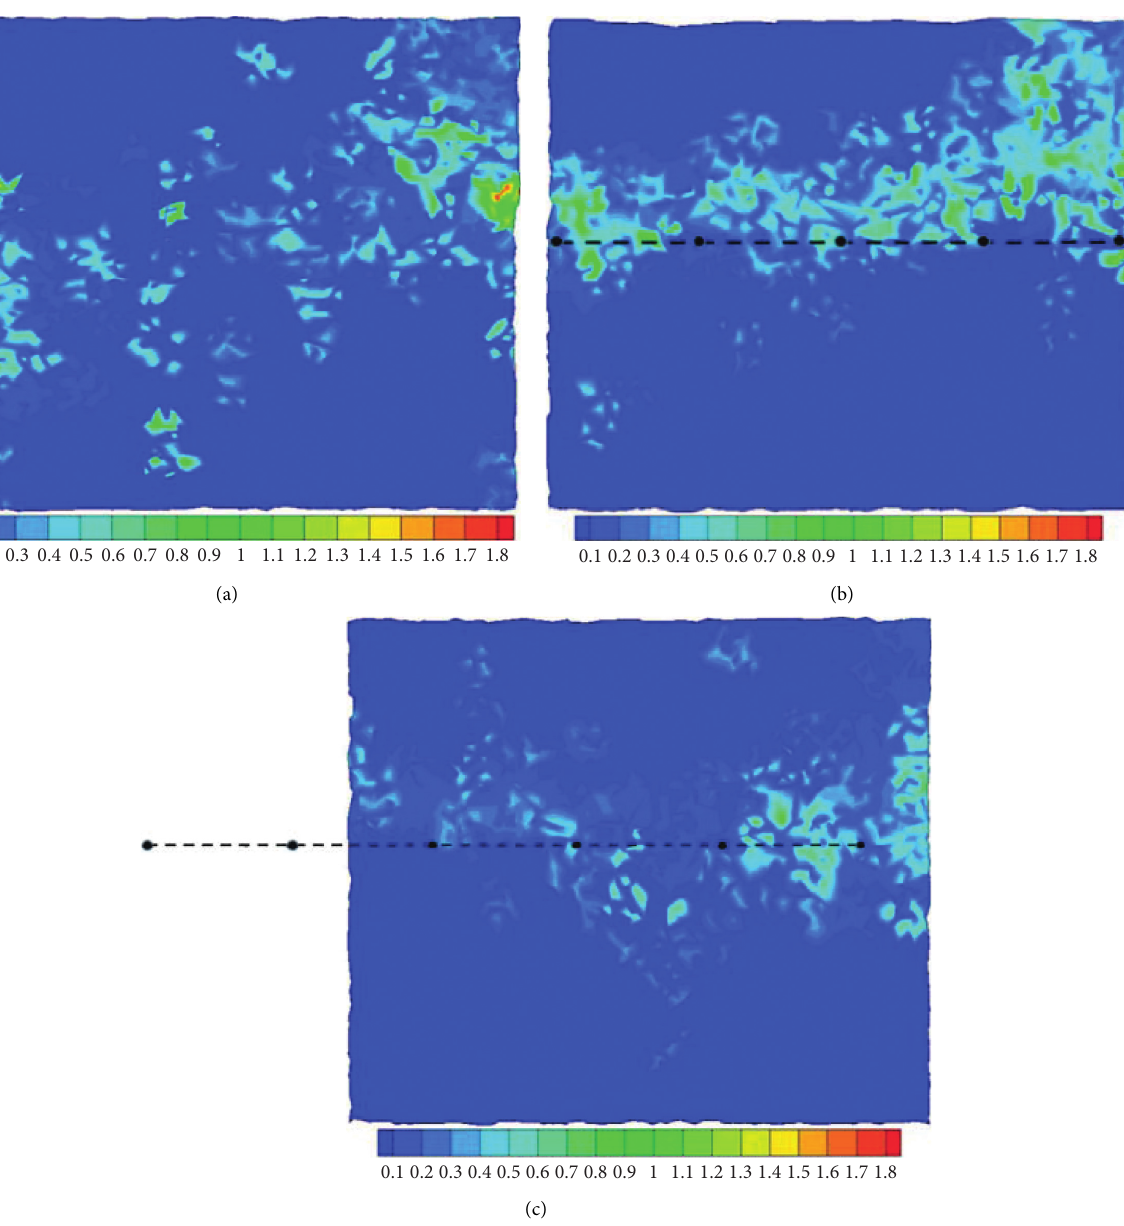
Figure 9: Nominal volumetric strain. (a) Direct shear test of unreinforced specimen. (b) Direct shear test of reinforced specimen. (c) Pull- out